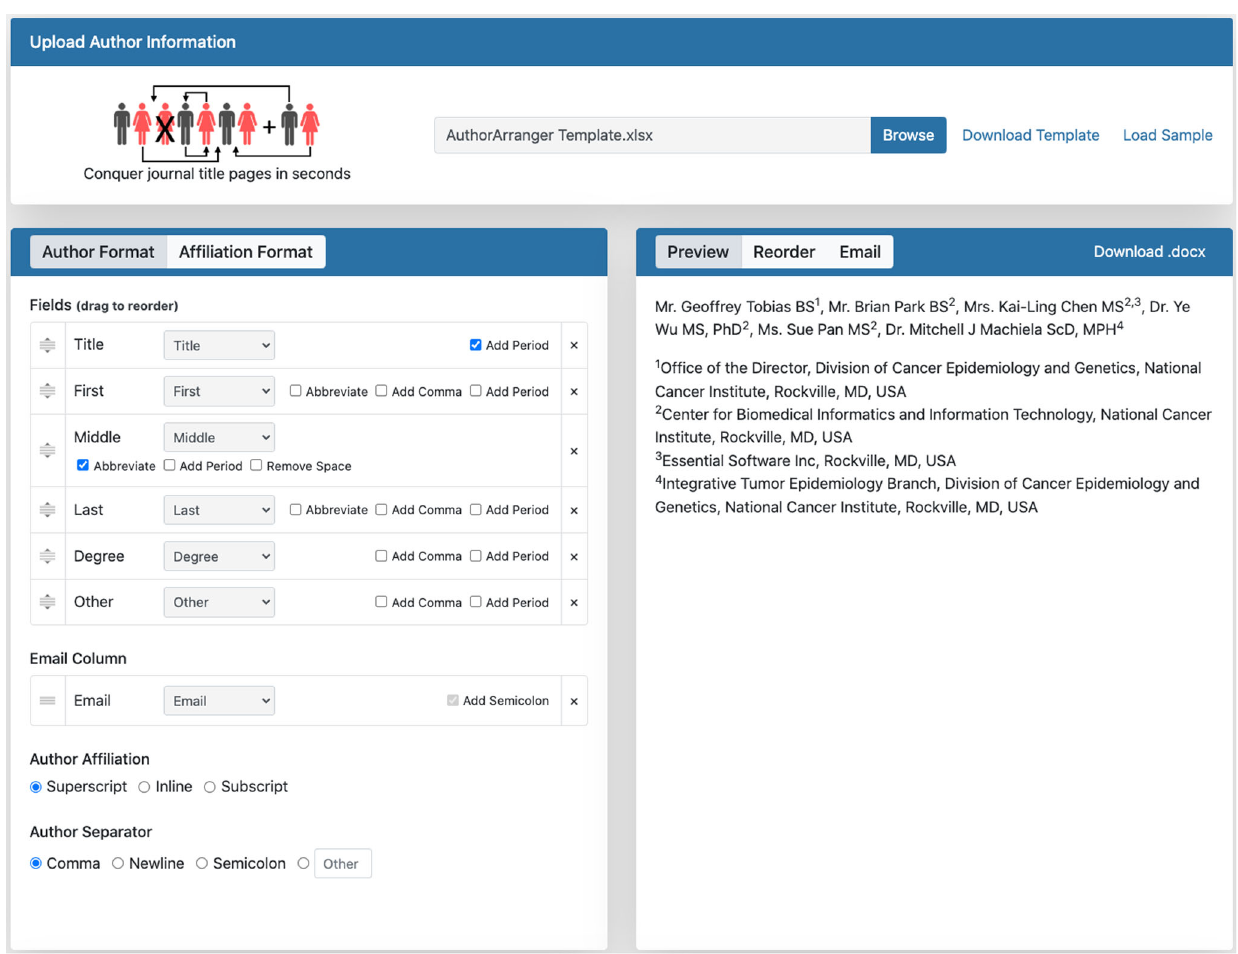
Fig. 1 AuthorArranger screenshot. Screenshot of AuthorArranger demonstrating features and fl exibility of the free and publicly available online platform to conquer journal title pages in